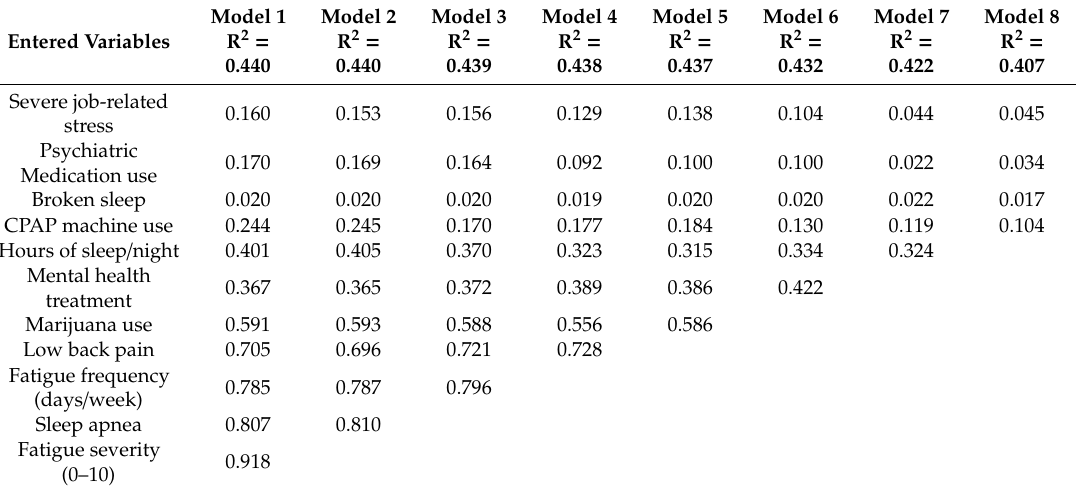
Table 2. Predictors of self-reported depressive symptoms.